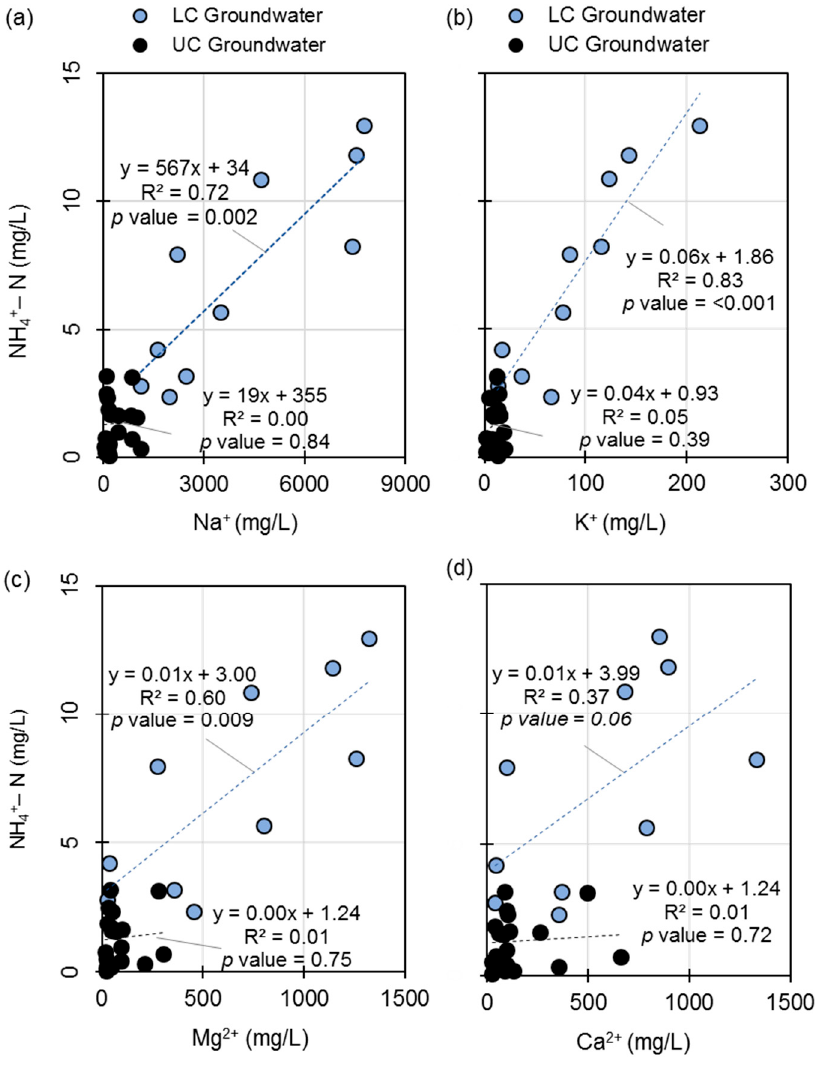
Figure 8. Relationship of NH 4+ –N and Na + ( a ), K + ( b ), Mg 2+ ( c ), Ca 2+ ( d ) in groundwater samples.